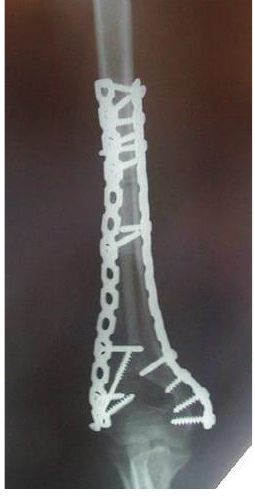
Figure 6: Postoperative X-ray.